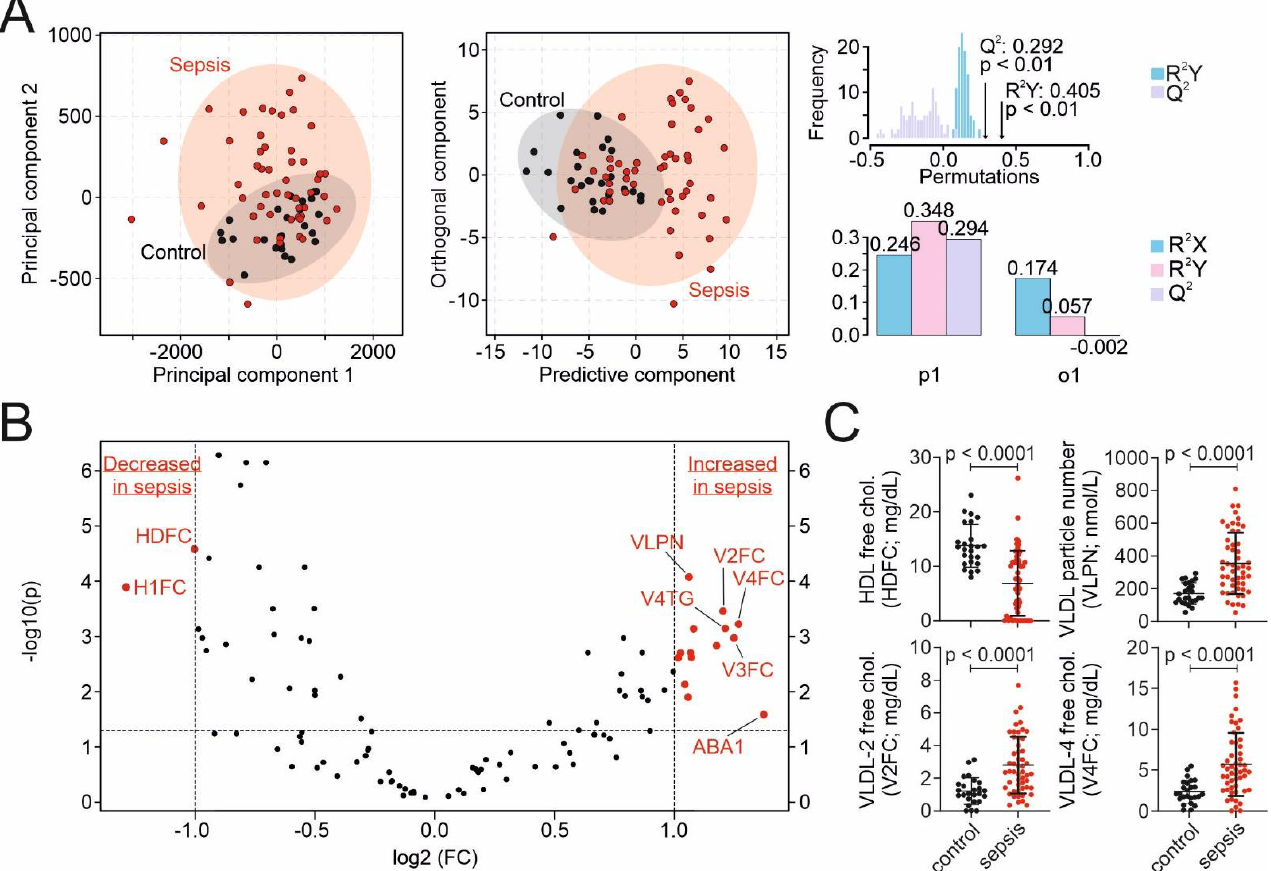
Figure 1. Targeted metabolomic assessment of lipoproteins. ( A ) Multivariate data analyses of lipoprotein parameters with principal component analyses (PCA) and orthogonal partial least squares discriminant analysis (O-PLS-DA) for the differentiation between ICU controls (black) and sepsis patients (red). PCA: principal component (PC) 1 of 76.8% and PC2 of 11.0%. O-PLS-DA: correlation coefficient R²Y = 0.405 and cross-validation score Q 2 of 0.292 ( p < 0.01). ( B ) Differences in lipoproteins between sepsis and control patients on a logarithmic scale (volcano plot). The vertical dashed lines mark the border to two-fold changes. The horizontal dashed line marks the level of significance at 0.05. ( C ) Boxplots of the most significant and most changed lipoproteins of sepsis (red color) and control (black color) patients. Abbreviations: HDFC = high density free cholesterol; H1FC = HDL-1 free cholesterol; VLDL = very-low-density lipoprotein; VLPN = VLDL particle number, V2FC = VLDL-2 free cholesterol; V3FC = VLDL-3 free cholesterol; V4FC = VLDL-4 free cholesterol; V4TG = VLDL-4 triglycerides; ABA1 = apolipoprotein B100 to apolipoprotein A-I ratio. Table 2. Lipid parameters in ICU sepsis patients and ICU controls assessed by targeted metabolomic analyses. Variables Sepsis Patients (N =